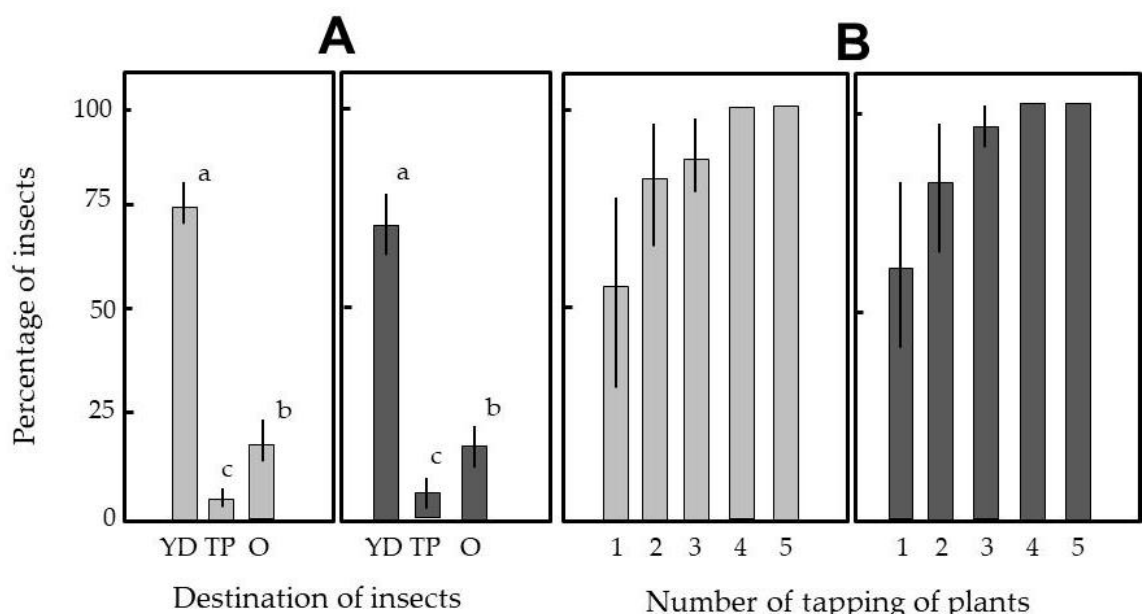
Figure 8. ( A ) Comparative assay of insects’ photoselective responses to yellow-colored double-charged dipolar electric field producers (DD-EFPs). Triplicated DD-EFPs (YD) were placed in front of three potted tomato plants (TP) in the closed film house; whiteflies (gray columns) and vegetable leafminers (black columns) were simultaneously blown inside the film house. At 2 h after insect release, the numbers of insects captured by the DD-EFPs, insects settled on tomato leaves, and insects remaining on other surfaces (O; floor, wall, or ceiling of the film house) were counted. ( B ) Comparison of the numbers of test insects attracted to DD-EFPs from plant leaves after single or repeated plant tappings. Insects were transferred onto tomato leaves and the leaves were tapped to cause the insects to fly from the plants. The numbers of insects captured by the DD-EFPs were counted after each tapping operation. Twenty insects were used for each species, and the means and standard deviations were calculated from five replicates of the experiments. The letters (a–c) on each vertical column in (A) indicate significant differences ( p < 0.05) according to Tukey’s test.